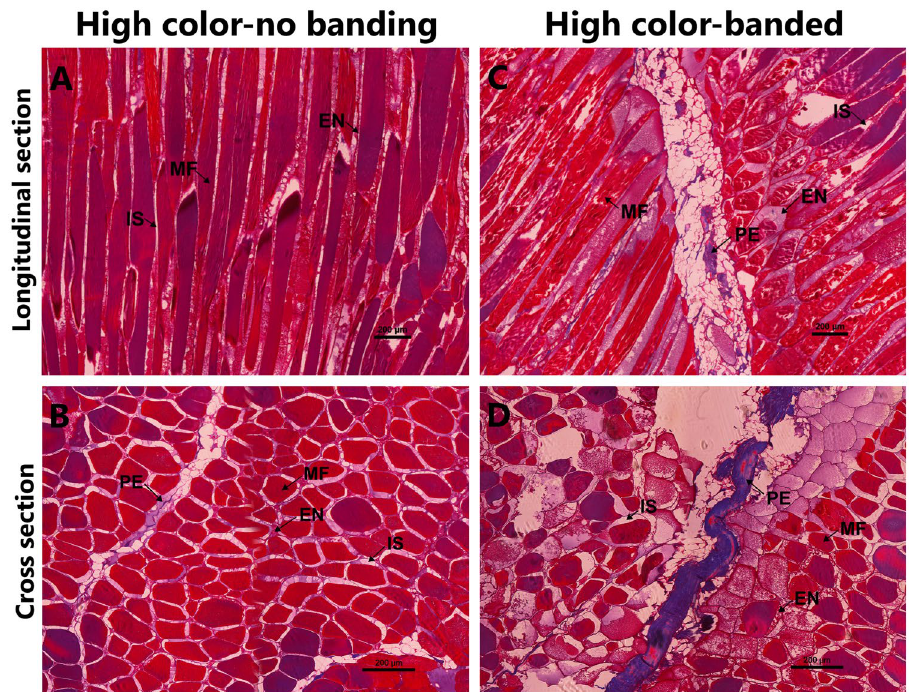
Figure 2. Microscopy images of the front dorsal (FD) muscle region showing structural variations among HN ( A , B ) and HB fish ( C , D ). Panels ( A , C ) present longitudinal sections, while panels ( B , D ) show cross sections,